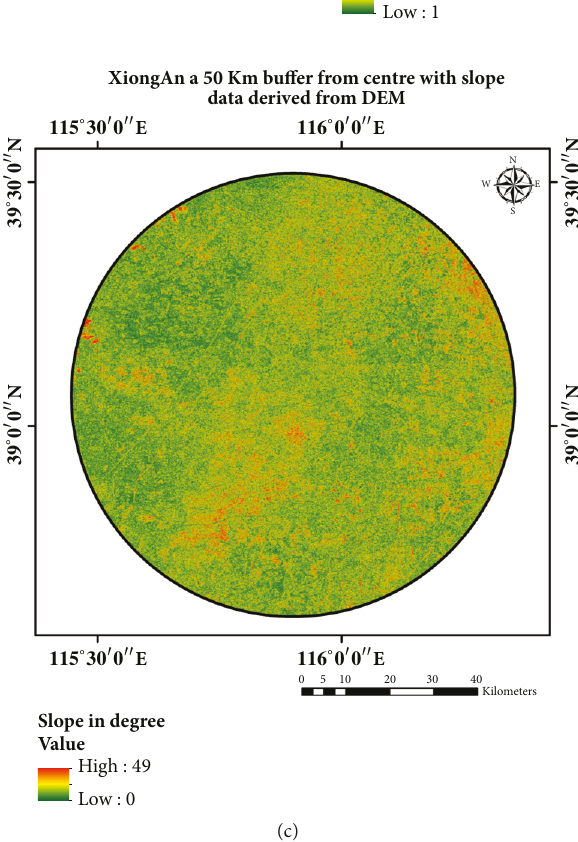
Figure 6: XiongAn satellite